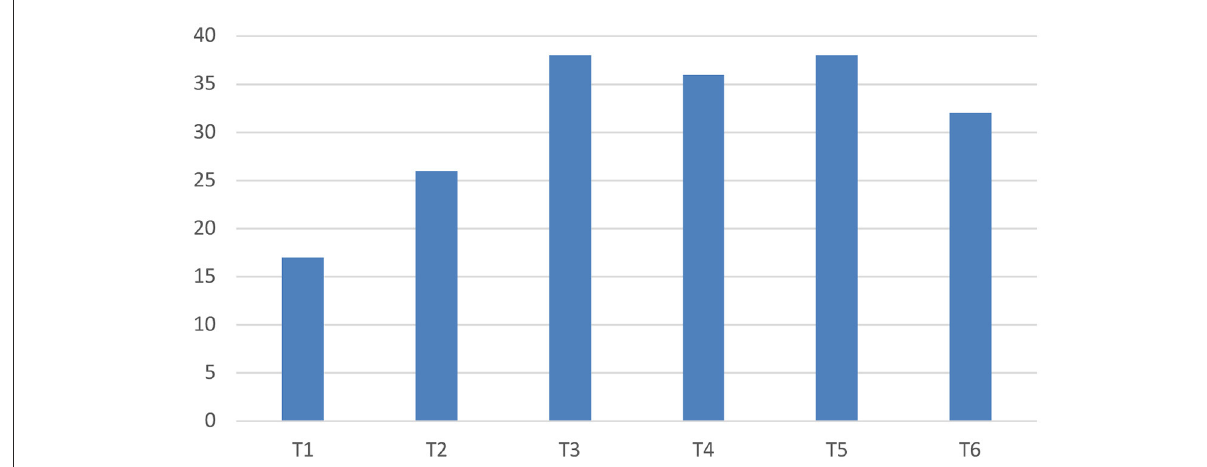
FIGURE3 Lesion location if a single vertebral body is considered.